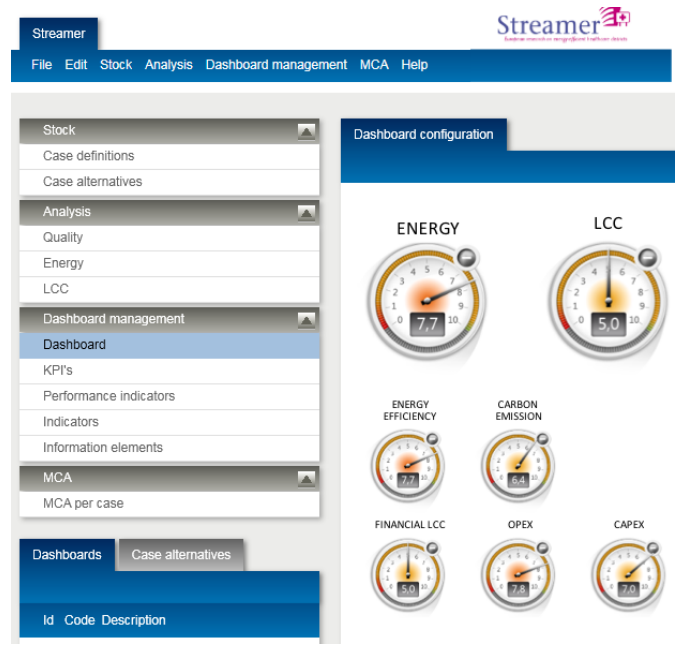
Figure 10. Visualizing the key performance indicators (above) and underlying performance indicators (below) for a design proposal in the